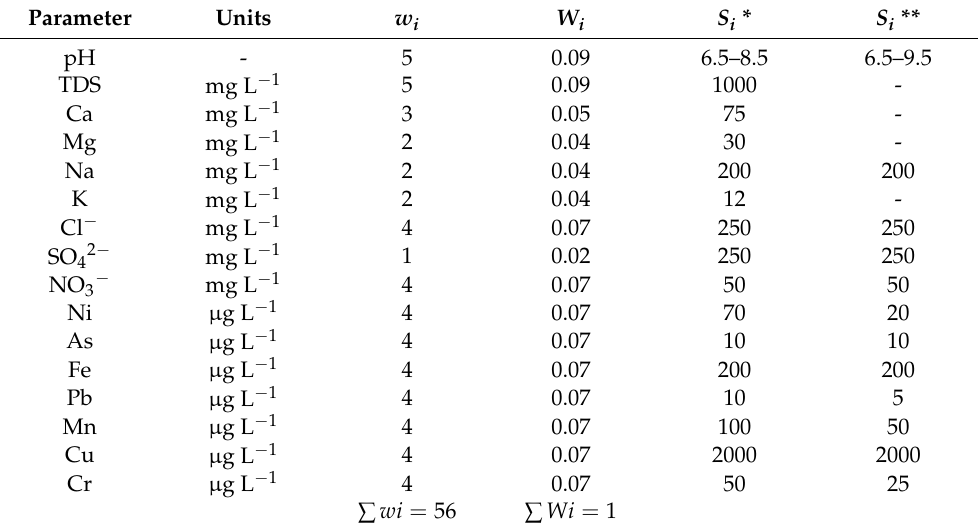
Table 3. Chemical parameters, weight ( w i ), relative weights ( W i ), and guideline value ( S i ) used for the calculation of Water Quality